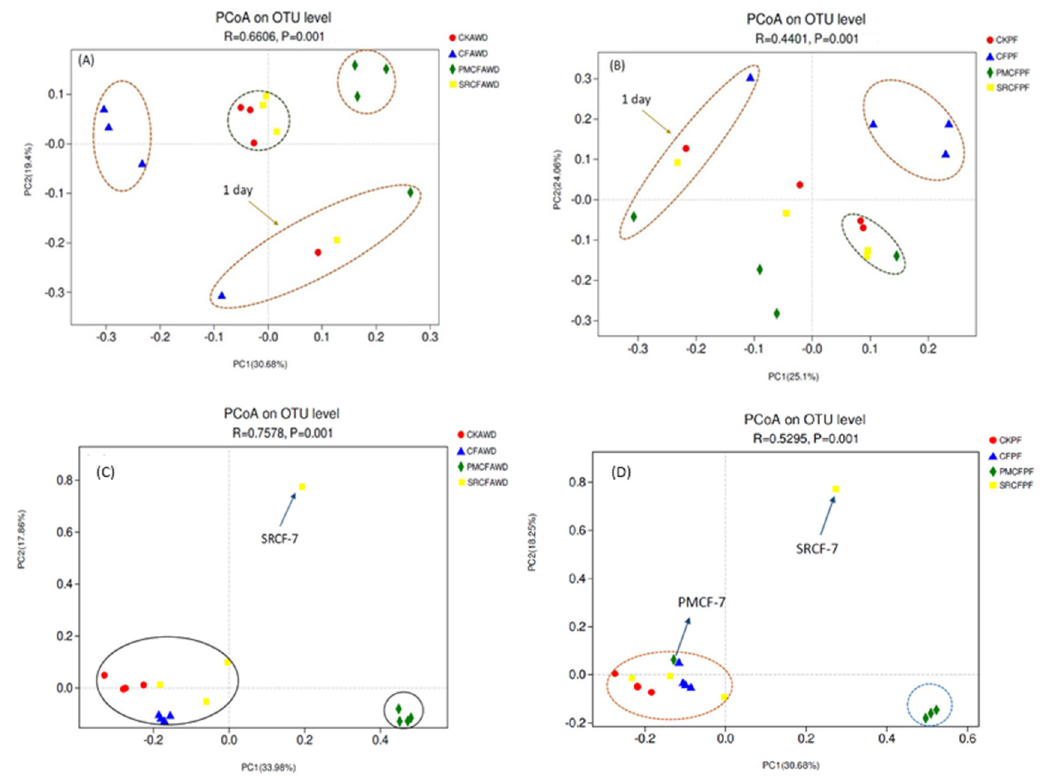
Figure 2. Principal component analysis (PCoA) of bacterial community compositions based on the Bray–Curtis distance for soils collected from long-term experiment plots of the unamended control (CK), chemical fertilizers (CF), pig manure plus chemical fertilizer (PMCF), and rice straw plus chemical fertilizer (SRCF) under alternate wet–dry (AWD) or permanent flooding (PF) conditions at 1, 7, 10, and 14 days after incubation. The PCoA of bacterial community compositions based on the Bray–Curtis distance under AWD and PF is represented by ( A , B ), while for fungal community compositions by ( C , D ) under AWD and PF, respectively.